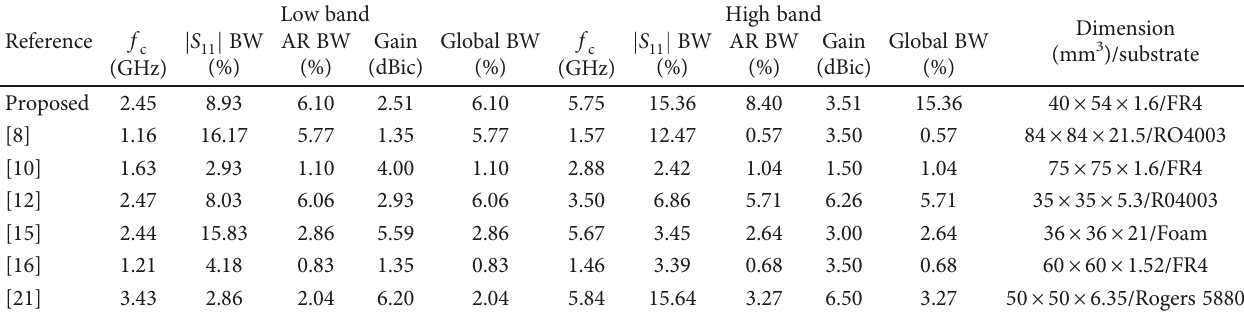
Table 2: The comparison of characteristics of the proposed antenna with the existing works.